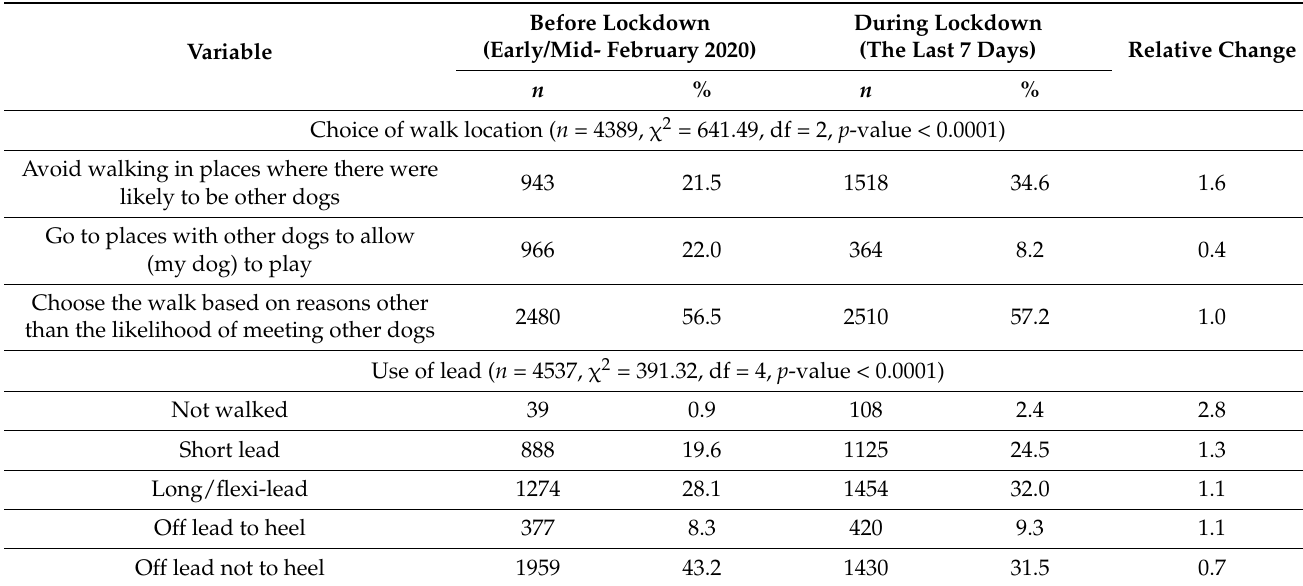
Table 4. Dog owners’ choice of walk location and use of lead when walking before and during the lockdown period.